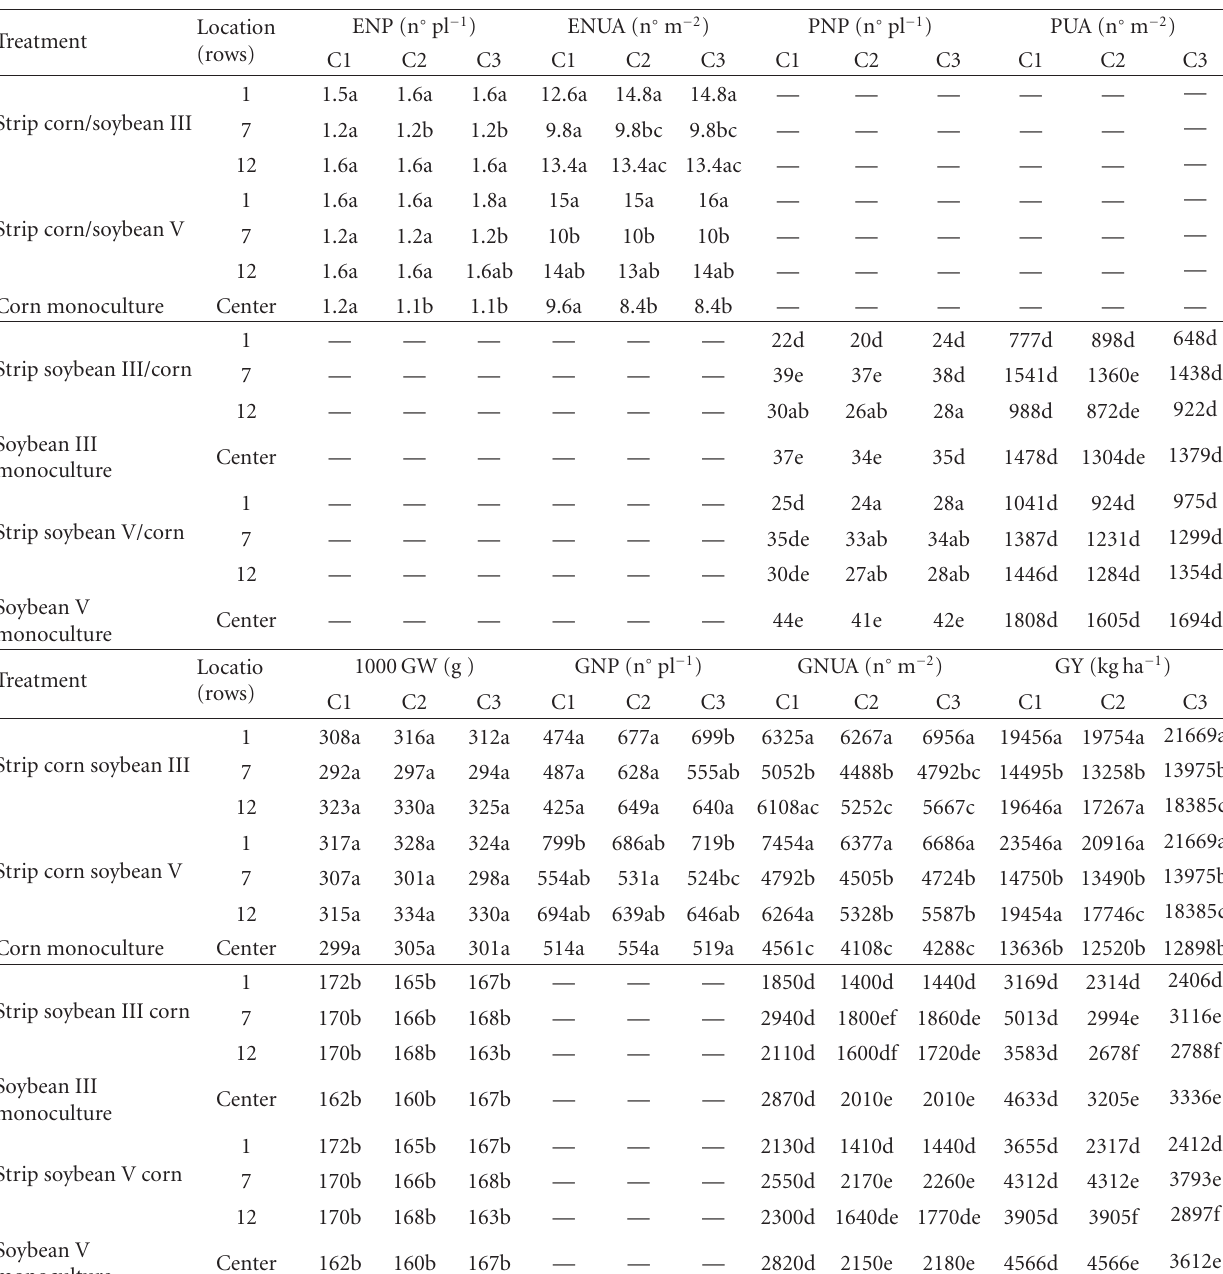
Table 3: Corn and soybean grain yield components and grain yield in monocultures and intercropped, during C1, C2, and C3. Ear number per plant (ENP, n ◦ pl − 1 ), ear number per unit area (ENUA, n ◦ m − 2 ), pods number per plant (PNP, n ◦ pl − 1 ), pods per unit area (PUA, n ◦ m − 2 ), 1000-grain weight (1000 GW, g), grain number per plant (GNP, n ◦ pl − 1 ), and GNUA (n ◦ m − 2 ), GY (kg ha − 1 ). Locations 1, 7, or 12